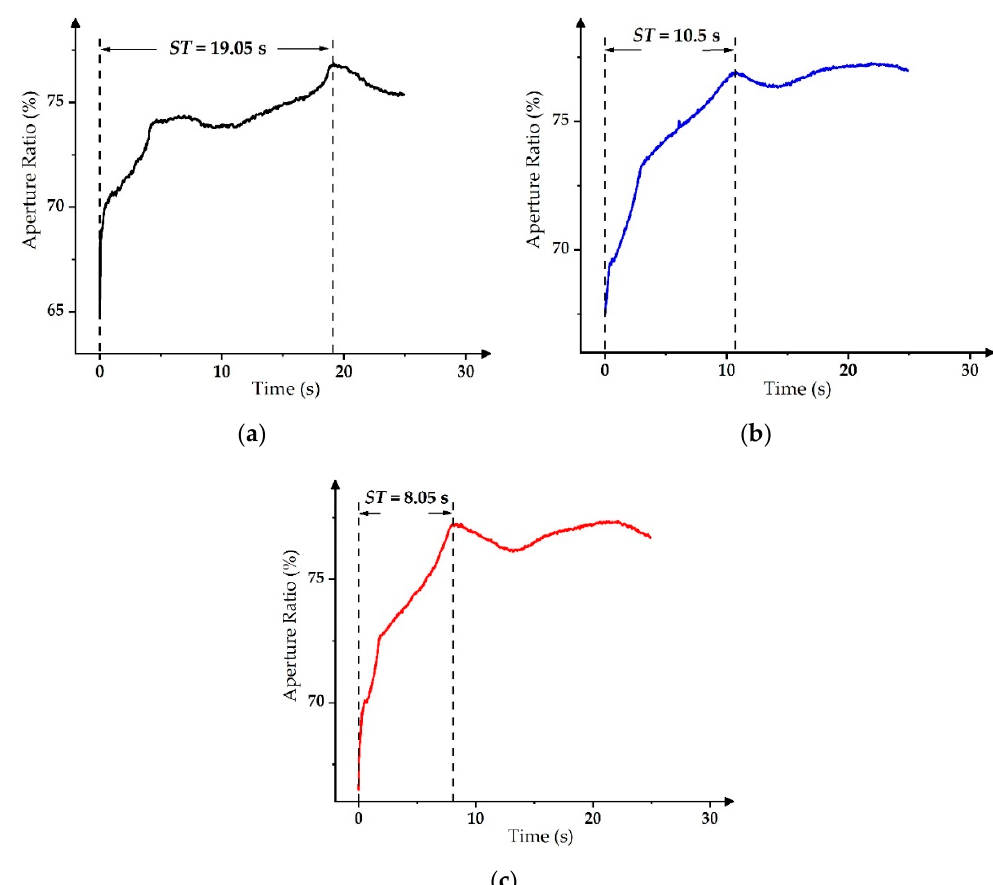
Figure 12. Driving time for the stable grayscale display of different driving waveforms. ( a ) The PWM with a duty cycle of 90% [14,30]. ( b ) The slope-driving waveform with K = 5 V/ms [17,31]. ( c ) The exponential function with τ = 4 ms.